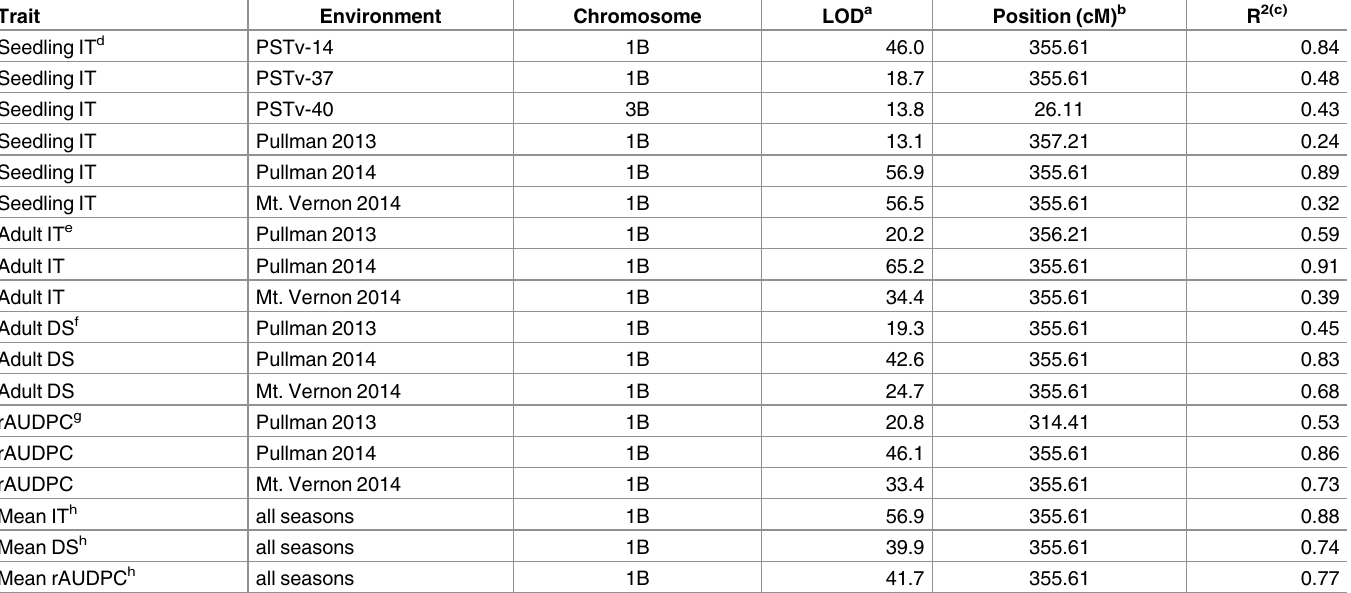
Table 1. Quantitative trait loci associatedwith stripe rust resistance in the AvS × PI 480035population.